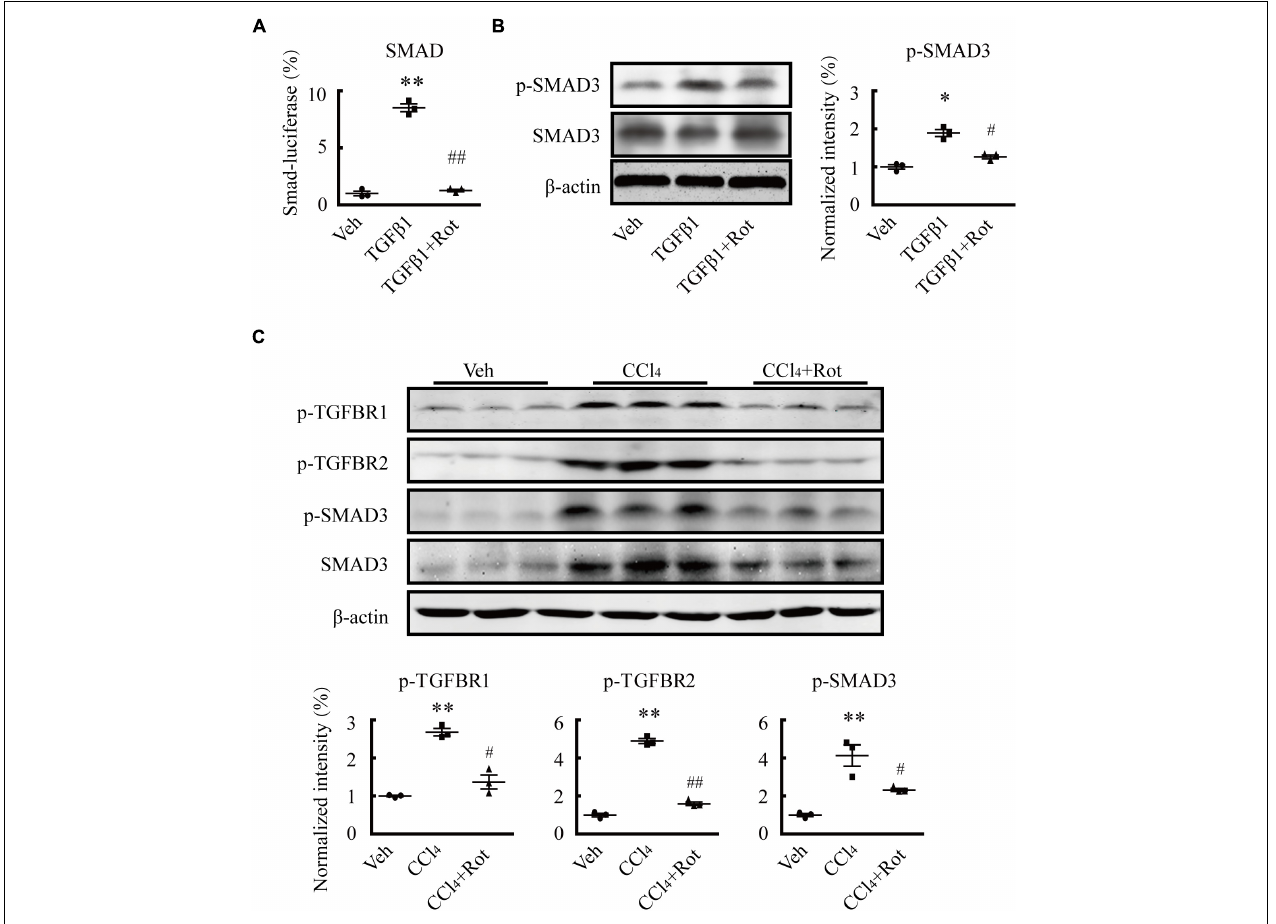
FIGURE 5 | Rottlerin exerts antifibrotic effects through inhibition of the TGF β 1/SMAD3 signaling pathway. (A) SMAD activity as measured by luciferase reporter assay using reporter vectors PGL4.48[luc2P/SBE/Hygro] in LX2 cells with the indicated treatments. SBE means SMAD binding element (** p < 0.01 compared with the vehicle (Veh) group, ## p < 0.01 compared with the TGF β 1-treated group; n = 3). (B) Representative western blots ( left ) and normalized intensity ( right ) of the p-SMAD3 levels in primary hepatic stellate cells (HSCs) treated as indicated. Phosphorylation levels of the SMAD3 protein were measured in serum-starved HSCs treated with TGF β 1 (4 ng/mL) for 1 h. Rottlerin (3 µ M) was applied to the medium for 6 h before TGF β 1 application ( ∗ p < 0.05 compared with the Veh group, # p < 0.05 compared with the TGF β 1-treated group, n = 3). (C) Representative western blots ( left ) and normalized intensity ( right ) of the levels of total and/or phosphorylated proteins, as indicated, in liver tissues from vehicle, CCl 4 , and rottlerin-treated rats with CCl 4 -induced fibrosis (** p < 0.01 compared with the Veh group, # p < 0.05, and ## p < 0.01 compared with the CCl 4 -treated group, n =